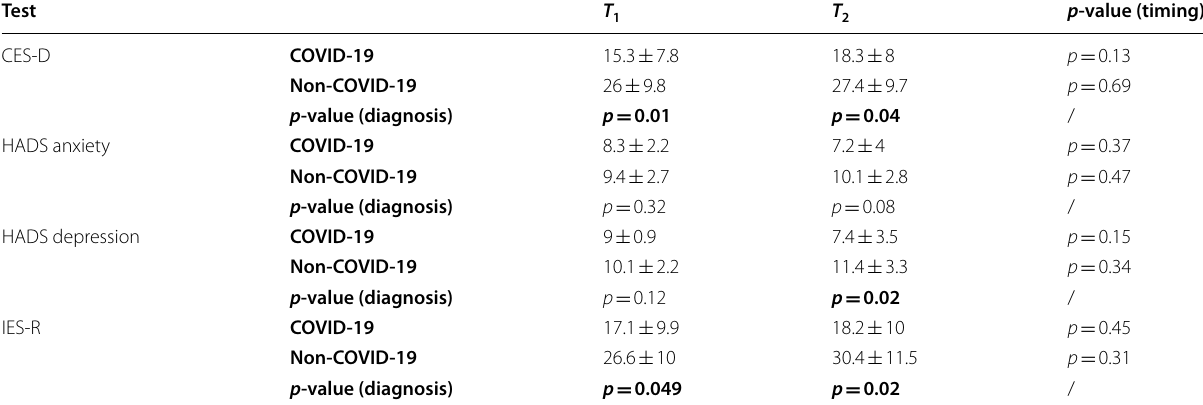
COVID-19 Coronavirus disease 2019, CES-D Center for Epidemiologic Studies Depression (depression), IES-R Impact of Event Scale-Revised, HADS Hospital Anxiety and Depression Scale (depression or anxiety version)